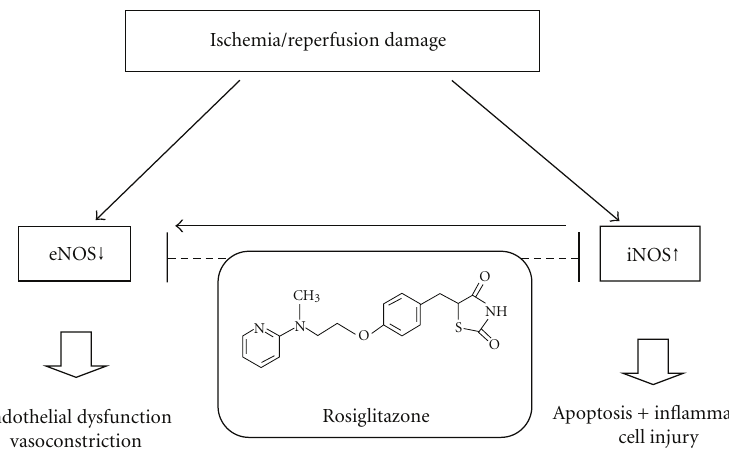
Figure 7: Schematic figure of factors contributing to renal dysfunction in ischemia/reperfusion injury. The downregulation of eNOS causes endothelial dysfunction and vasoconstriction. The upregulation of iNOS in acute kidney injury is associated with an increase in cell apoptosis and inflammatory cell damage. Moreover, elevated levels of iNOS directly suppress the expression of eNOS. The application of rosiglitazone in ischemic acute kidney injury and reperfusion may help to correct the imbalance of eNOS/iNOS